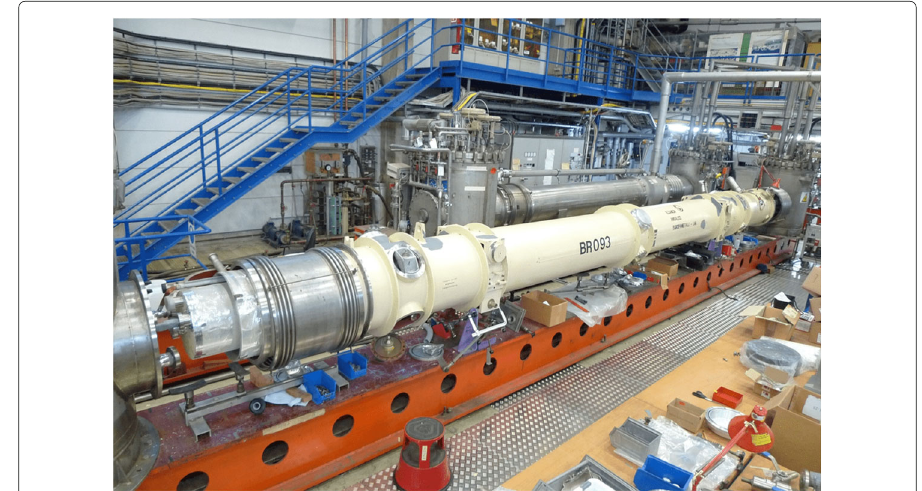
When the survey of the beam pipe during the straightening of the magnet (see “The survey of the vacuum pipe” section) was completed, the Helium lines between the boxes and the magnet were sealed by special Aluminium seals. Copper half shells were connected around the bellows in the Helium pipes, to prevent them from buckling when pressurized. The Helium pipes, and the magnet at the flanges were shielded from thermal radiation with super insulation (see “The new suspensions” section) after leak checking the connections of the Helium pipes. Then the open flanges and the sliding sleeves on the vacuum tank (see Fig. 7) were closed, to evacuate the vacuum vessel. At about 10 − 4 mbar in the vacuum vessel, the cool down of the cold mass to 4K